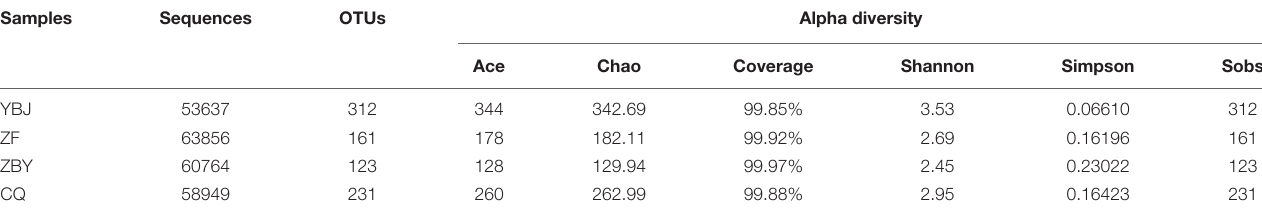
TABLE 2 | The species richness and diversity index of soil fungal in the Oxytropis glacialis root system.